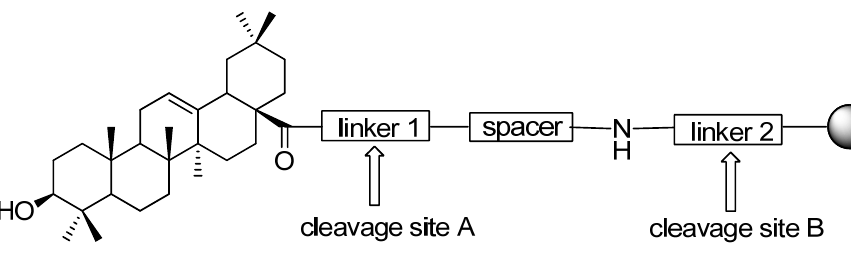
Figure 2. Diagram of the dual linker for OA solid phase